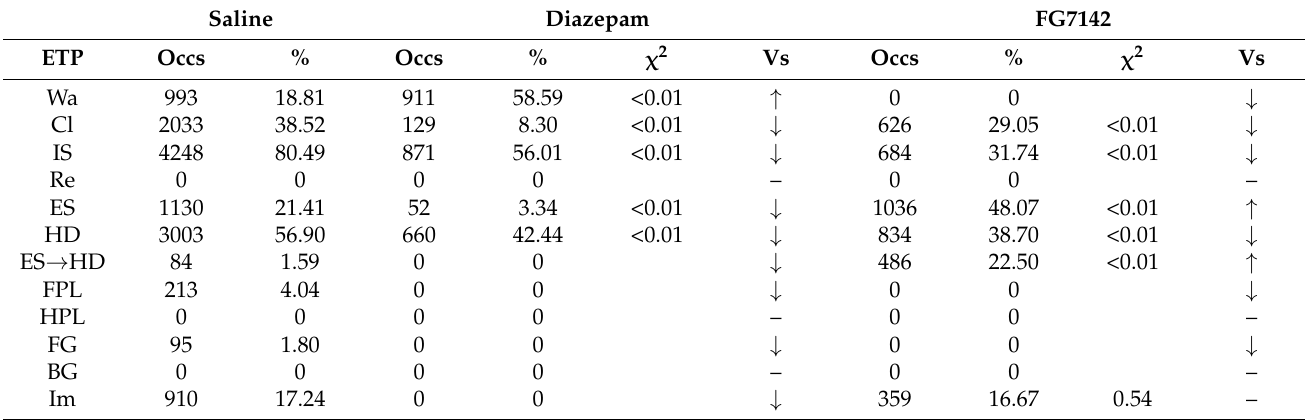
Table 1. Overall number and percent of T-patterns encompassing each behavioral